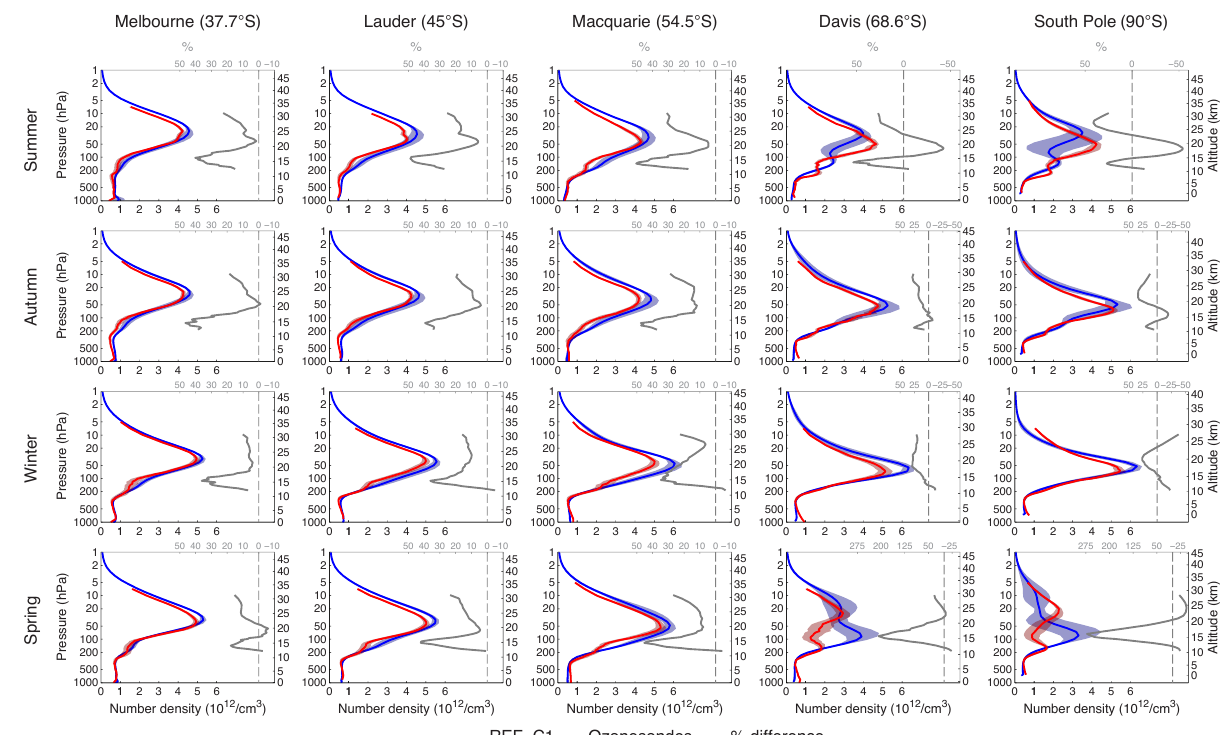
Figure 4. Seasonal average REF-C1 ozone profiles compared to ozonesondes for Melbourne, Lauder, Macquarie Island, Davis and the South Pole. REF-C1 and ozonesonde data are averaged between 2005 and 2010. Shaded regions show 1 standard deviation for REF-C1 and 1 √ standard deviation divided by 7 . 5 for the ozonesonde data. This is done for statistical consistency as monthly averaged output was used for the REF-C1 data (see Sect. 4.3 in the main text). Altitude values are approximate. The grey lines show REF-C1 percentage differences from ozonesondes, following the top x